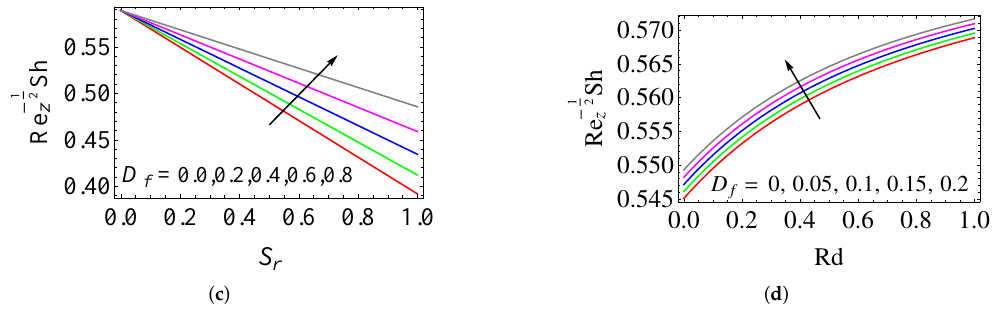
Figure 12. Influences of ( a ) thermal radiation ( Rd ) , ( b ) thermal stratification ( G 1 ) and ( c , d ) Dufour number ( D f ) parameters on Sherwood number.